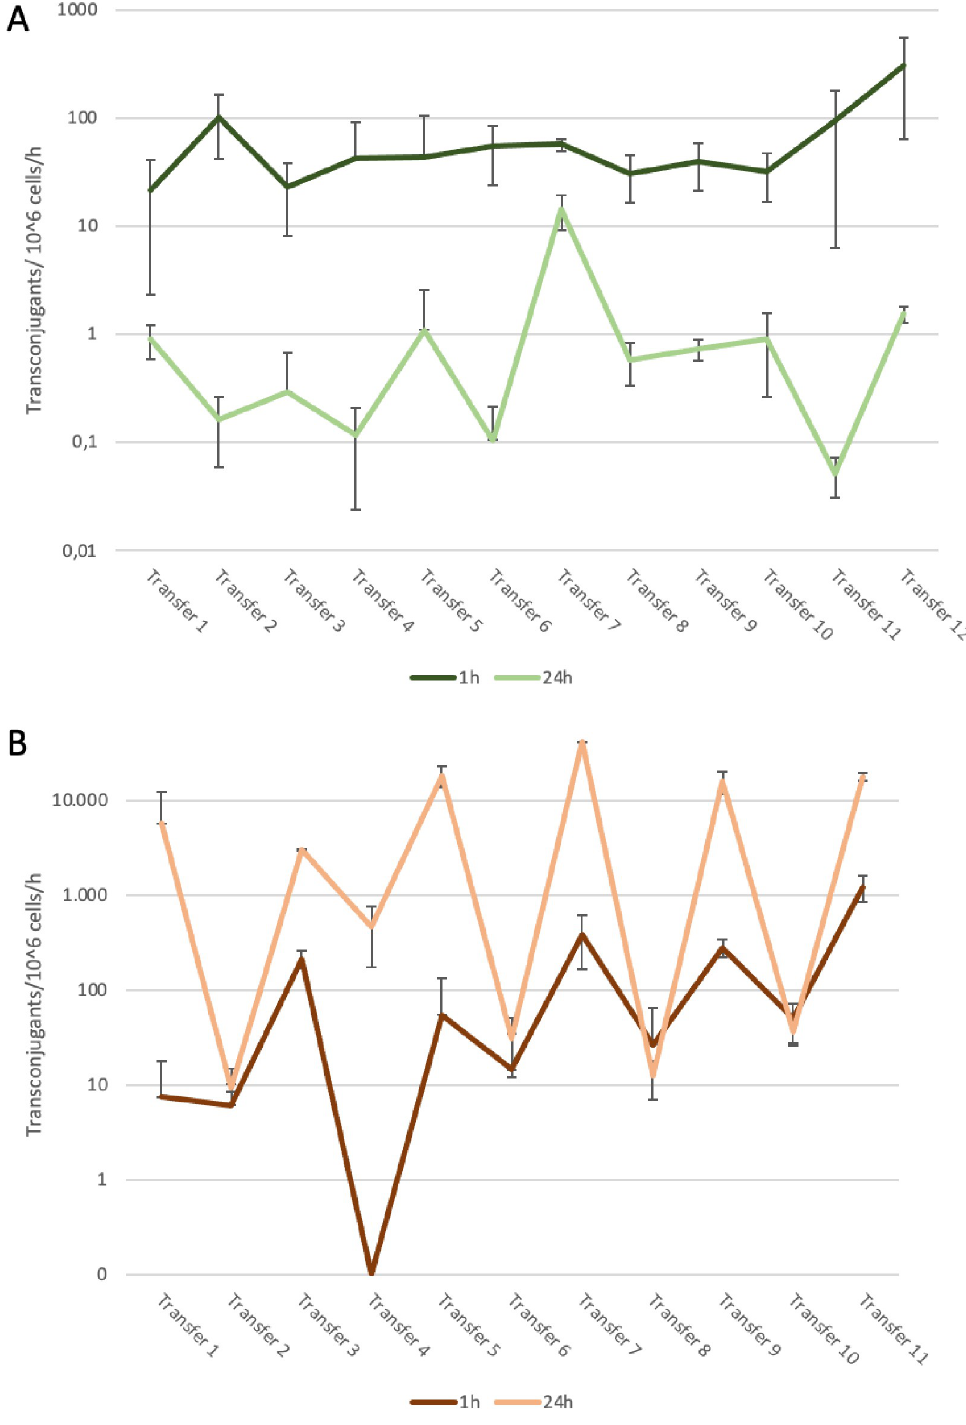
Fig 3. Transconjugants per million cells per hour found after multiple transfers with standard method of transfer( A ) or addition of glucose ( B ) measured after 1 and 24 hours. Two recipient s were used: E . coli JW3686 with kanamycin resistance (uneven transfers) and E . coli MG1655 with chloramphenicol resistance (even transfers). The obtained transconjugants were used as a donor strain for the next transfer round. Standard deviations are shown but are distorted because of the use of the log